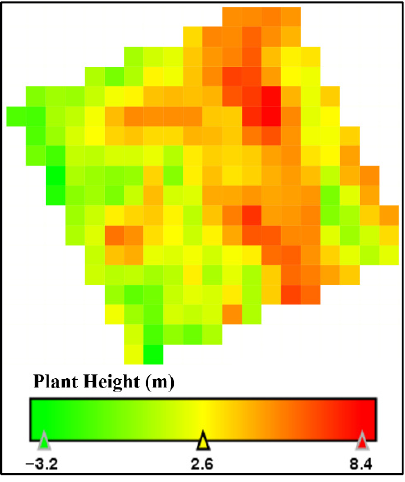
Figure 13. Maize heights calculated by subtracting DTM from DSM. Table 6. Minimum, maximum, and average plant height calculated using Sentinel-1 satellite image pairs and standard deviation.